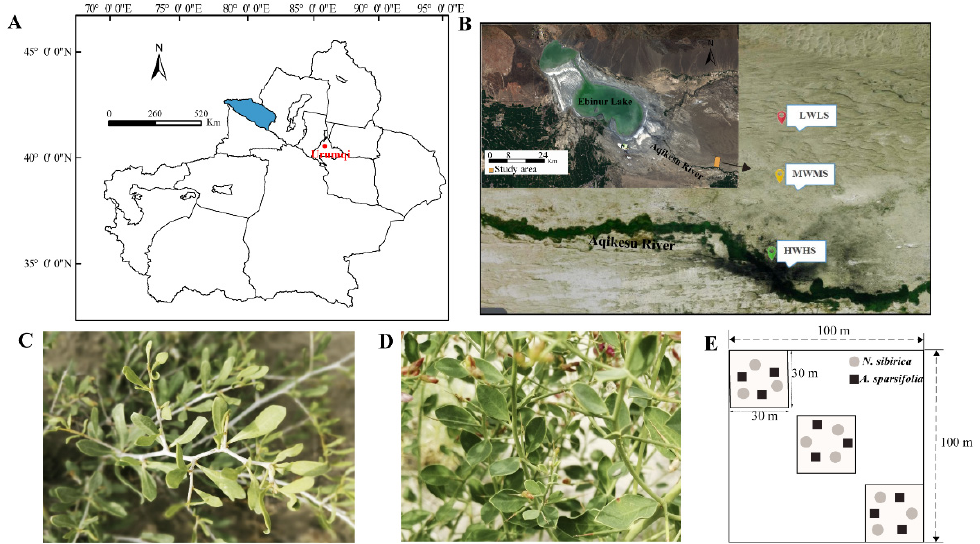
Figure 1. The study area and plots. ( A ) Location map of the Xinjiang Uygur Autonomous Region; ( B ) Location of the study area; ( C ) Leaves of the N. sibirica ; ( D ) Leaves of the A. sparsifolia ; ( E ) The two plants selected for each plot.